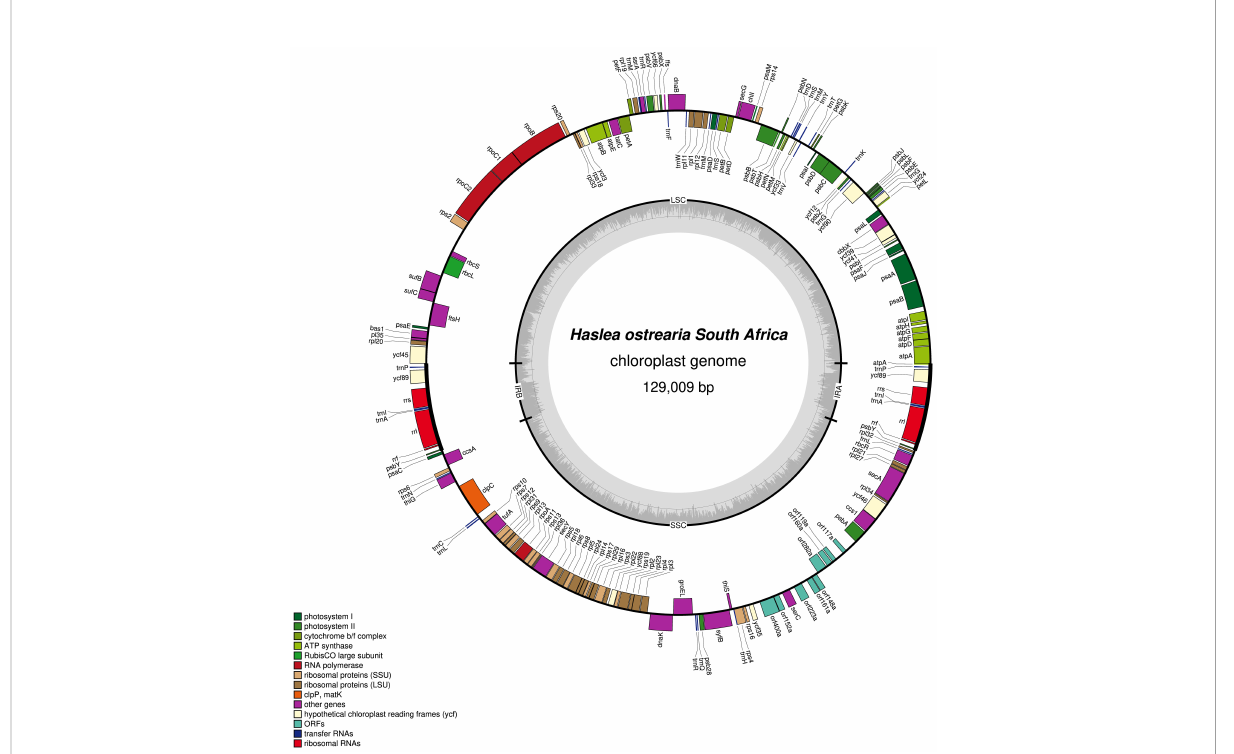
FIGURE 5 Map of the plastid genome of Haslea ostrearia SZCZP1883. The legend in the lower left part of the graph indicates the type of genes and features represented. Genes displayed on the outside were found on the positive strand, genes displayed on the inside were found on the negative strand. The grey graph indicates the GC content.